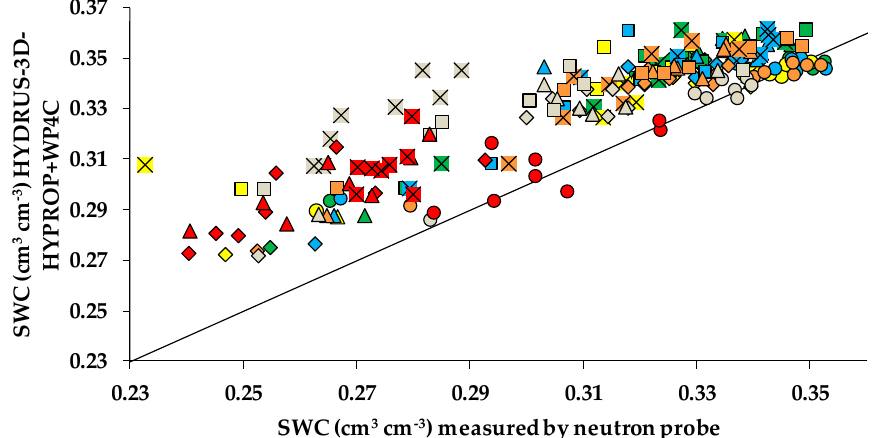
Figure 5. Soil water content (SWC) simulated with HYDRUS-3D parameterized from HYPROP + WP4 versus average measurements by neutron probe on 8 different dates in the 2018 irrigation season. Colors indicate access tubes (green = A, yellow = B, blue = C, orange = D, grey = E and red = F) and shapes indicate depths ( = 20 cm, = 40 cm, ∆ = 60cm, ☐ = 80 cm and ✕ = 100 cm).